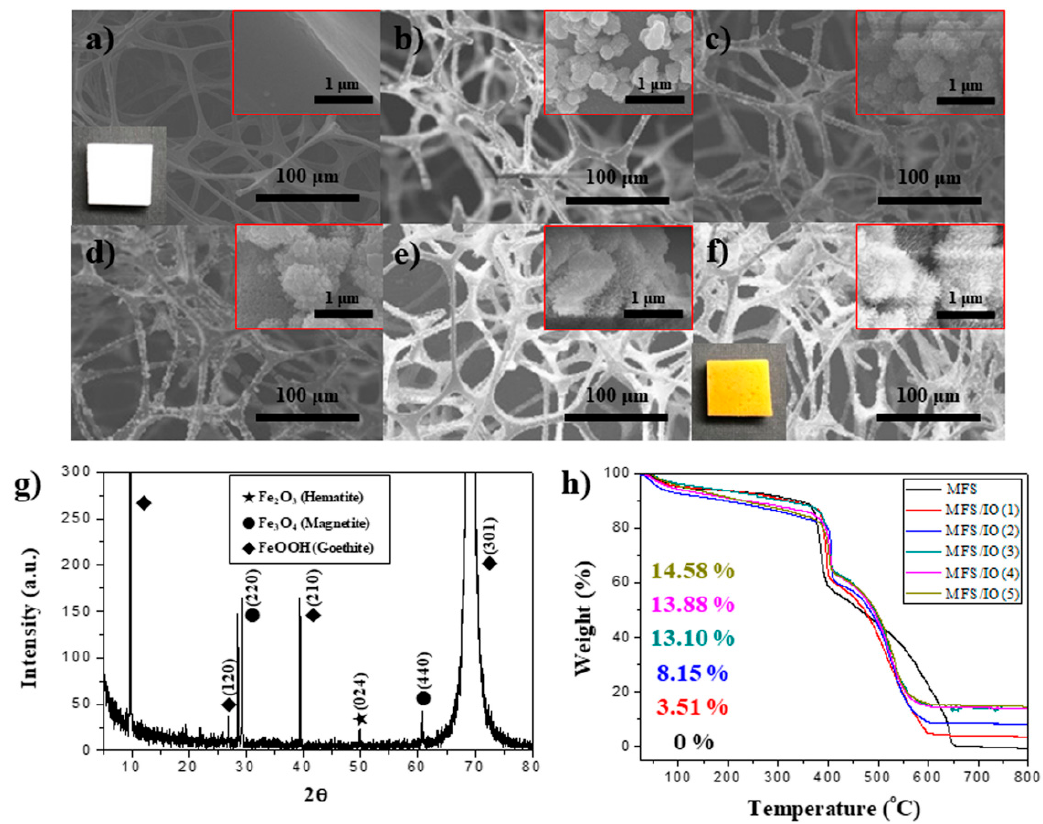
Figure 1. SEM images of MFS ( a ) before and ( b – f ) after IO synthesis. ( a ) MFS, ( b ) MFS / IO(1), ( c ) MFS / IO(2), ( d ) MFS / IO(3), ( e ) MFS / IO(4), and ( f ) MFS / IO(5). ( g ) XRD data of MFS / IO(3) as a representative of the IO-coated MFS samples. ( h ) TGA data for MFS and MFS / IO(1–5). Insets of ( a ) and ( f ) show the images of MFS and MFS / IO(5), respectively.